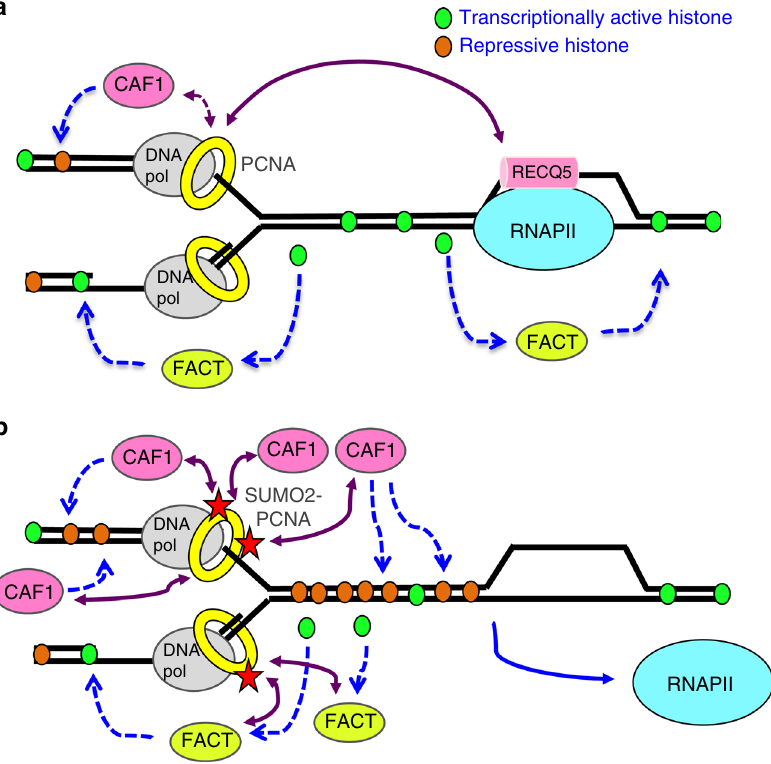
Fig. 8 Proposed model for SUMO2-PCNA-mediated TRC resolution. a Simultaneous interactions of RECQ5 with RNAPIIo and PCNA induce PCNA SUMO2 conjugation. Black lines represent DNA. Purple double arrows indicate protein – protein interactions. Single dashed arrows present histone chaperone activity. b SUMOylated PCNA enriches CAF1 and FACT in the replication complex to deposit repressive histones and reduce chromatin accessibility. Stars represent SUMO2. See text for